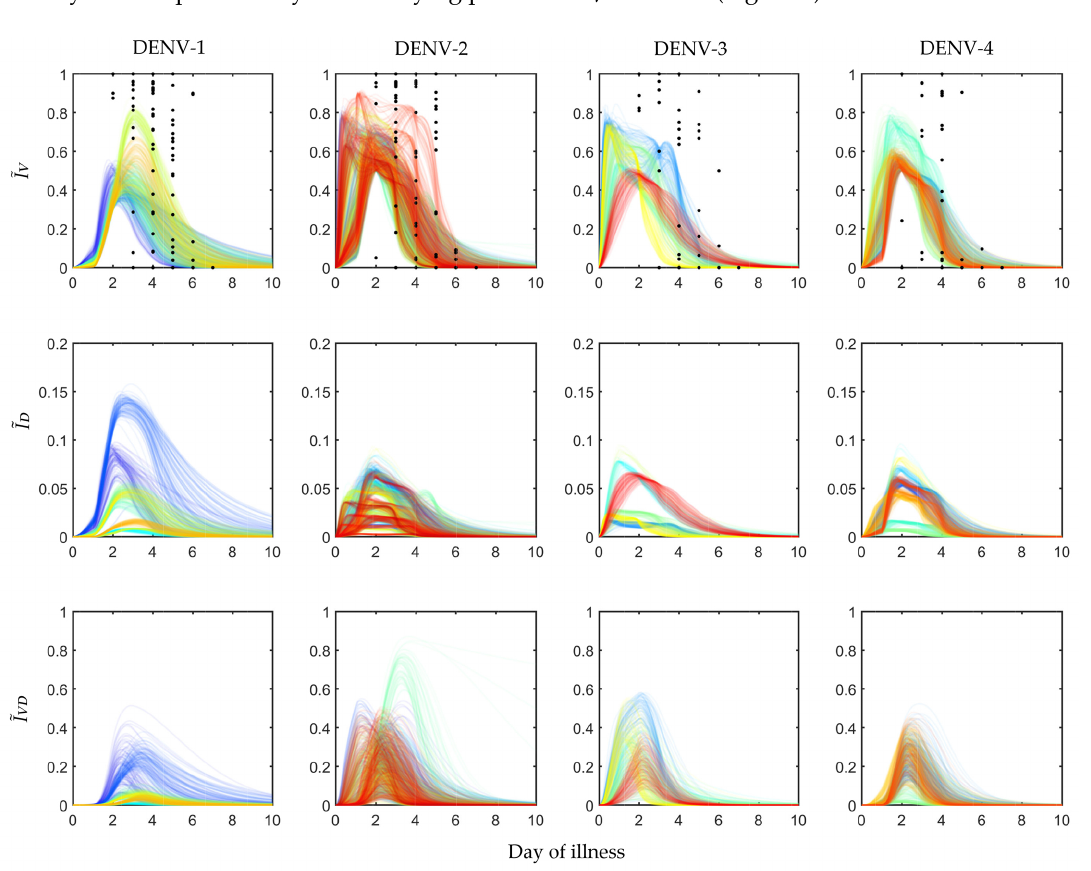
Figure 2. Population of models for infected mosquitoes: The dengue virus infected mosquito data for 408 exposure experiments with 208 hospitalised dengue patients reported in Nguyen et al. [33] are calibrated to construct serotype-specific population of models (POMs). The black scattered points in the top panel represent the fraction of viral infected mosquitoes (˜ I V ) observed in the exposure experiment. The group of lines in different colours (in the top, middle and bottom panels) are the calibrated POMs outputs for different patient models in the